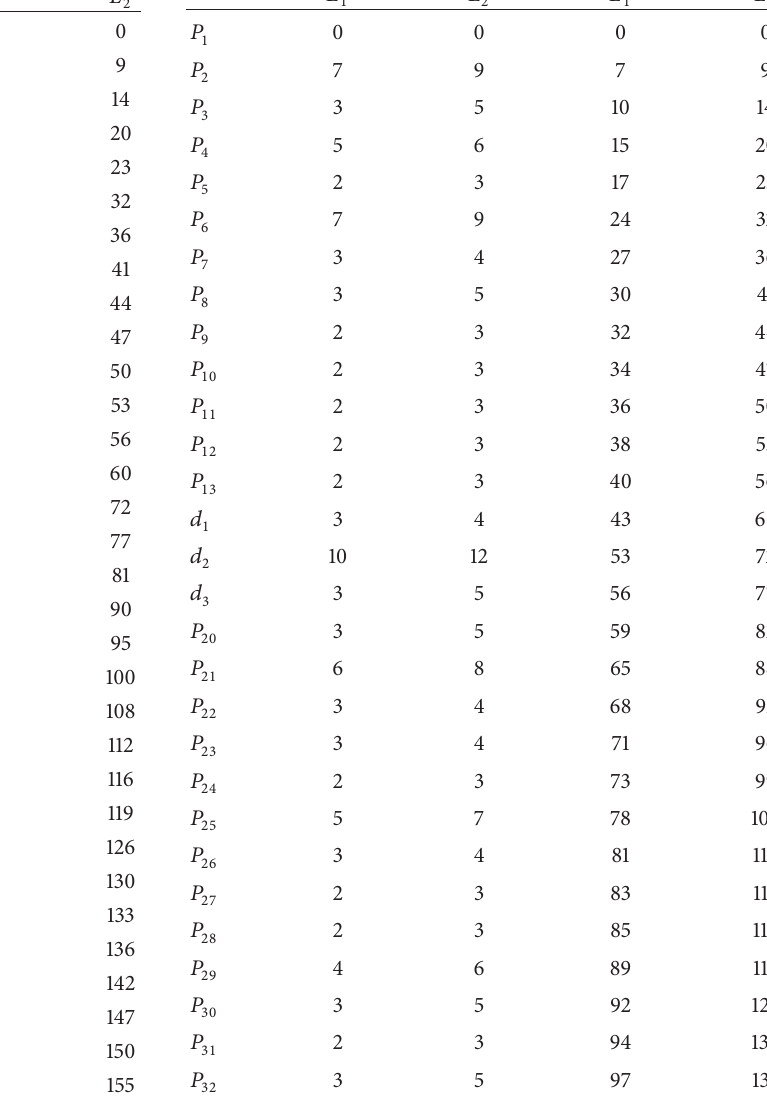
Table 4: Simplified upper and lower time limit corresponding to each